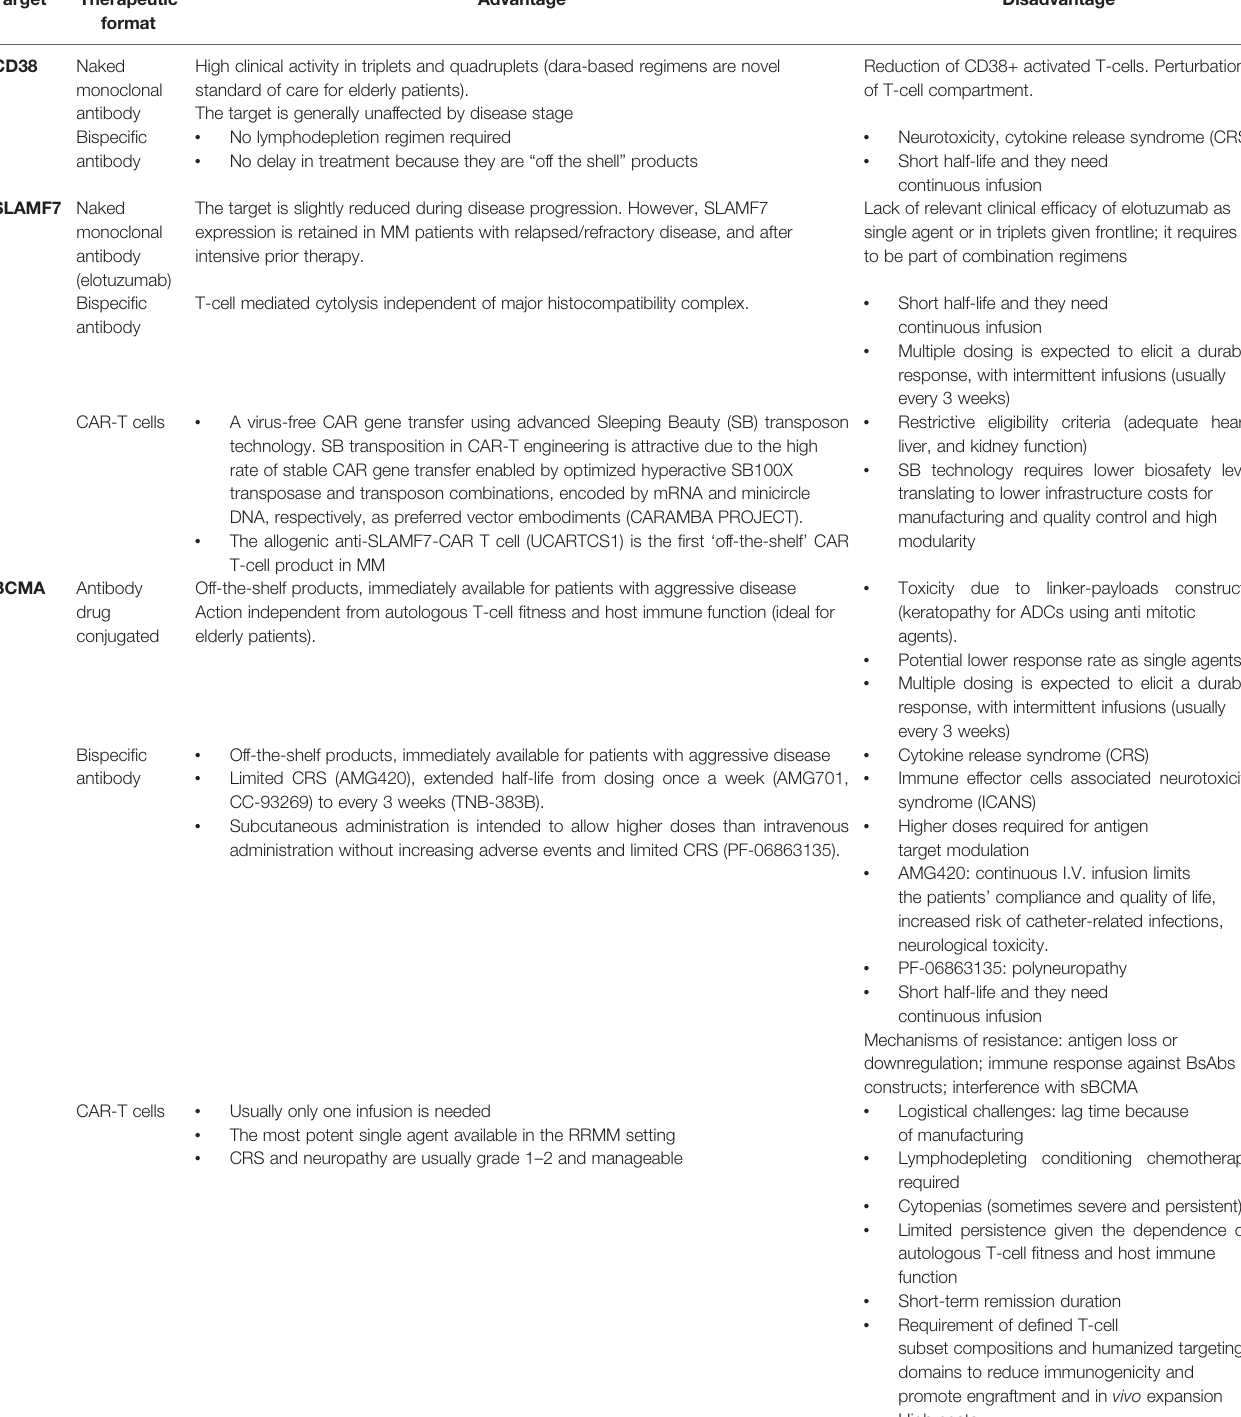
TABLE 5 | Vantages and Disadvantage of monoclonal antibodies, Bispeci fi c antibodies, Antibody drug conjugated and CAR-T cells. Target Therapeutic Advantage format